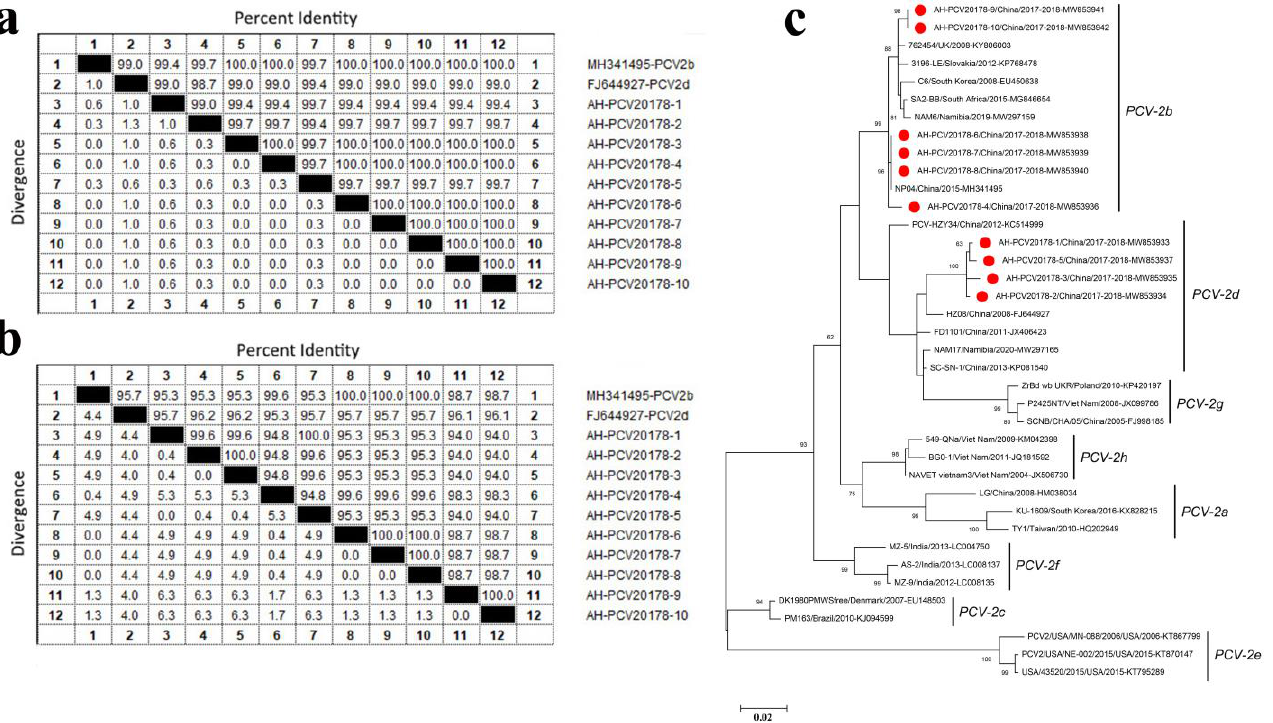
Figure 4. Porcine circovirus type 2 identified in sick pigs: (a), (b) The sequence comparison based on the amino acid sequences of Rep or capsid protein of ten PCV2 isolates identified in this study; (c) phylogenetic analysis based on the nucleotide sequences of the capsid of PCV2 identified in this study and reference strains of other PCV2s. PCV2s identified in this study are marked with a solid red circle.